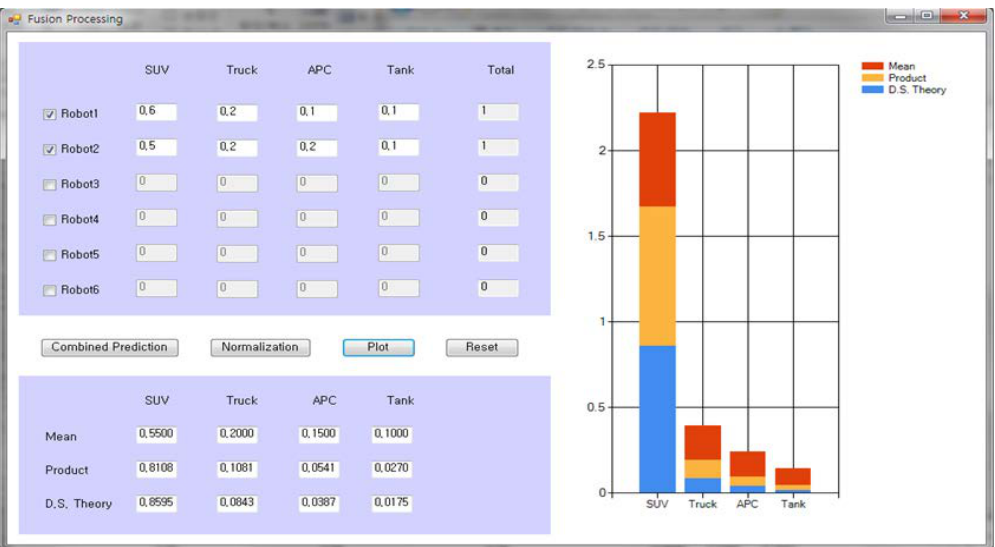
Figure 1. Fusion process using aggregation operators, i.e., mean, product, and DS theory.